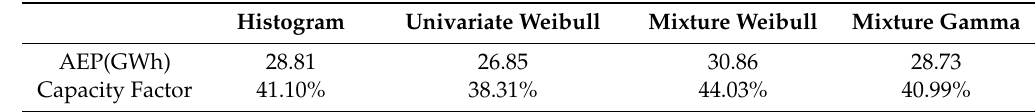
Table 4. Annual energy production and capacity factor.